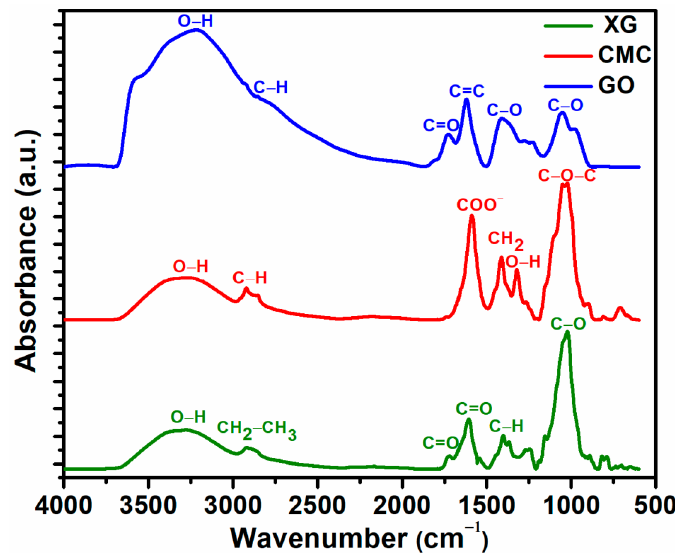
Figure 4. The FTIR spectra of pure XG, CMC, and pure GO.